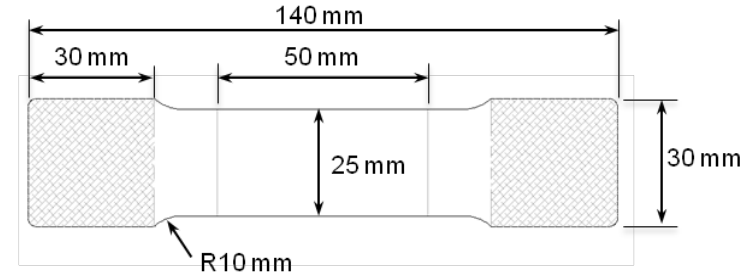
Figure 3. Specimen for cyclic loading test based on